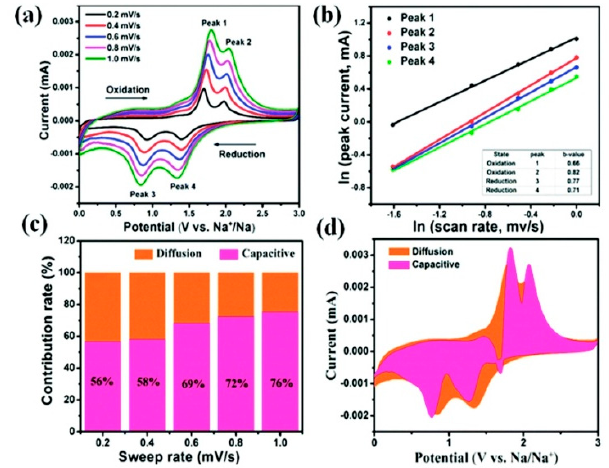
Figure 12. Electrochemical properties of NiS 2 particles (diameter ≈ 5 nm) embedded in porous carbon nanofibers (NiS 2 NP/p-CNF), as an anode. ( a ) Cyclic voltammograms at different scan rates; ( b ) the fitted lines of ln( i ) versus ln( v ) plots in different oxidation and reduction states; ( c ) The contribution ratio of capacitance at different scan rates (0.2, 0.4, 0.6, 0.8, 1 mV s − 1 ) of NiS 2 NP/p-CNF; ( d ) the area comparison of capacitive contribution to total storage in CV at 1 mV s − 1 . Reproduced with permission from [343]. Copyright 2017 Royal Society of Chemistry.